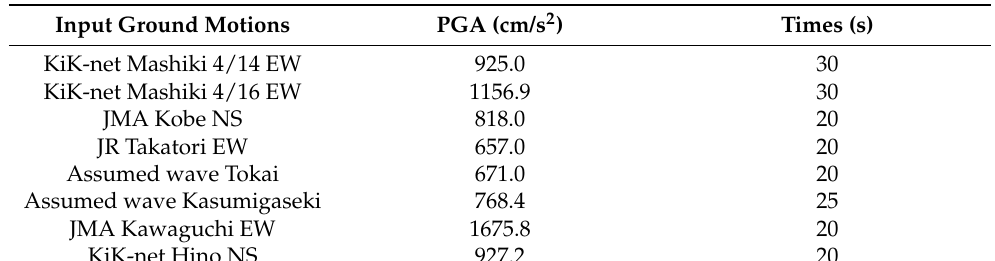
Table 6. Input ground motions.